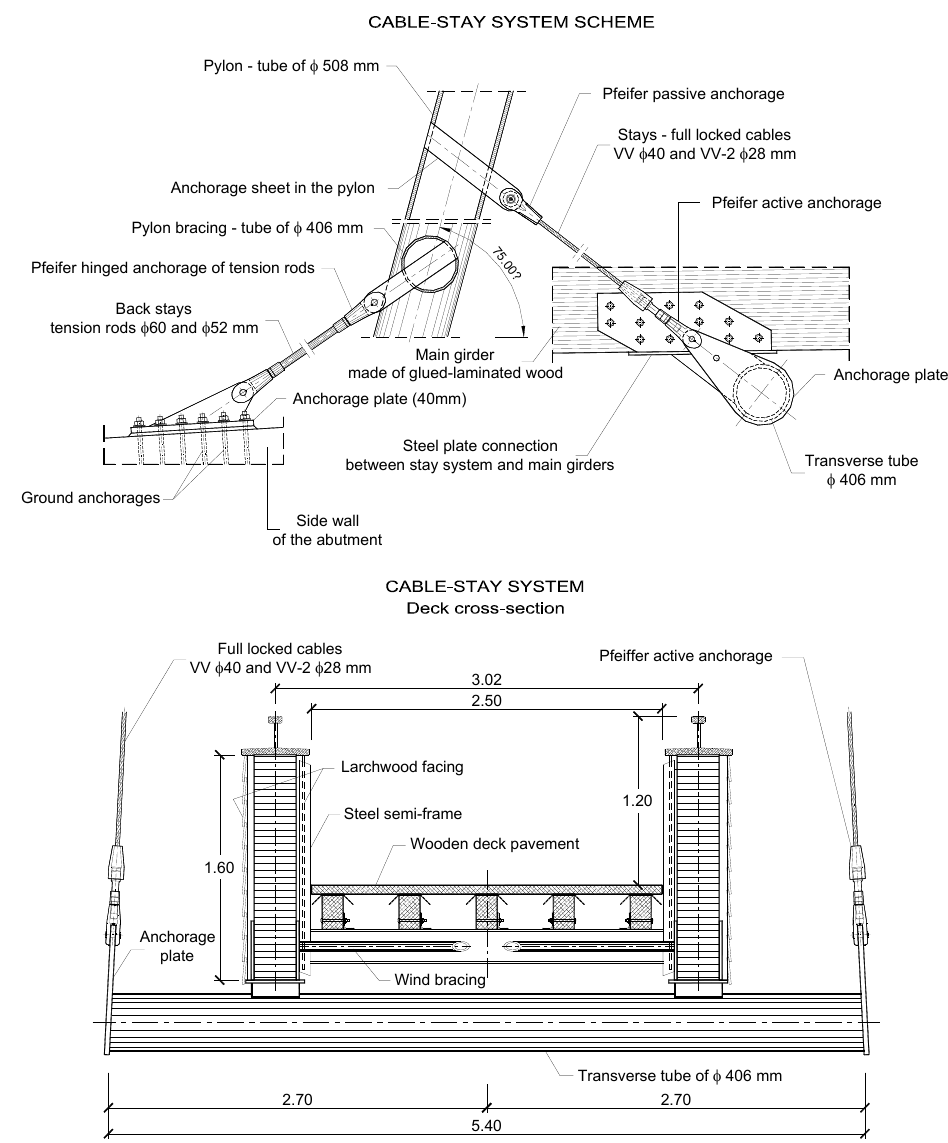
Figure 5. The stay cable system of the footbridge in the Pieniny mountains.